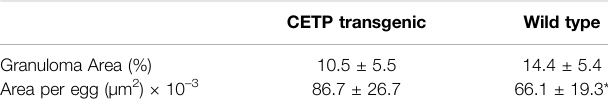
TABLE 1 | Granulomatosis lesions in the liver (Okumura-Noji et al.,